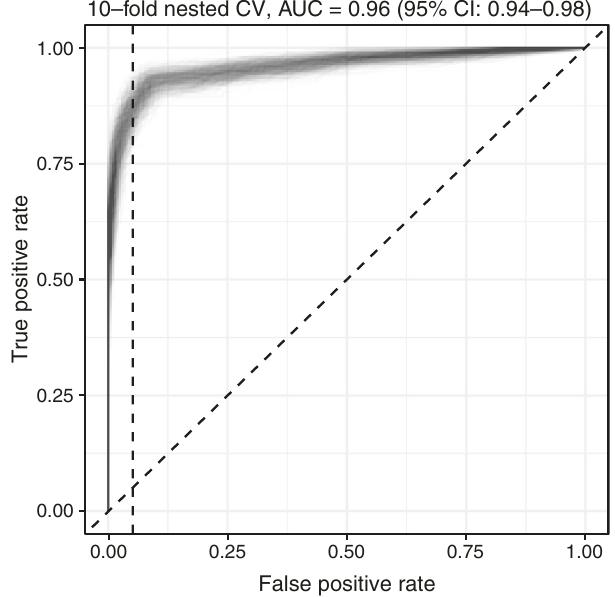
Fig. 6 | Cancer detection across cancer types. Receiver Operating Characteristic (ROC) curve for sample classi fi cation from the DELFI cohort, which included 199 individuals with cancer and 206 healthy individuals. A random forest model using ten-foldnested cross-validation with 500 iterations wasused to classifysamples as either healthy or cancer. This cohort consisted of stage I – IV NSCLC ( n =27); stage I – III breast cancer ( n =48); stage I – IV CRC ( n =27); stages I – IV, 0 and X gastric cancer ( n =27); stage I – IV ovarian cancer ( n =26); and stage I – III pancreatic cancer ( n =34). All ROC curves from 500 iterations are shown. Classi fi cation performance by individualcancertype and stage is shown inSupplementary Fig. 15. Source data areprovidedasaSourcedata fi le.AUCareaunderthecurve;CIcon fi denceinterval; CV cross